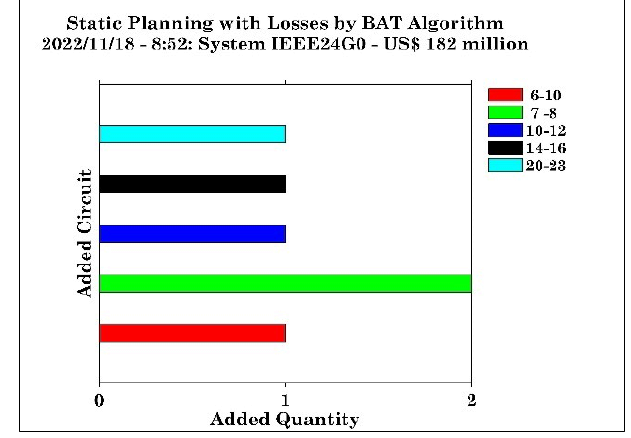
Figure 6: Case WR - IEEE-24/41 test system. Planned circuits. Source: BATp optimizer, (2022).